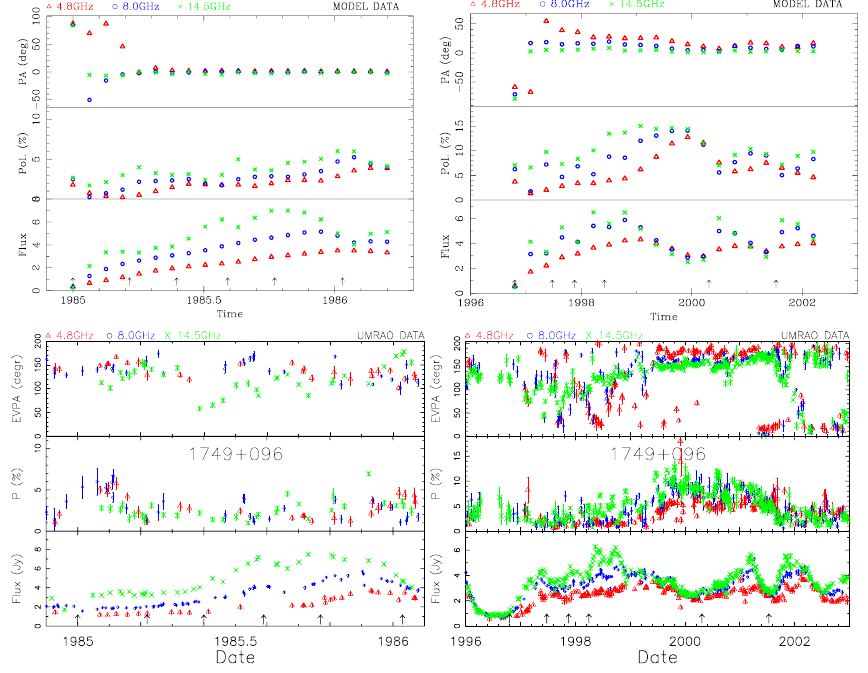
Figure 2. Comparison of the observed light curves in the form of daily-averaged data (bottom plots) and simulations (top plots) for epochs T1985 (left) and T1996 (right) showing time in years. The data at the three frequencies are symbol and color coded to match in the data and simulations. The simulated light curves were computed for 20 time steps using the adopted flow parameters listed in Table 1 and the values of the shock attributes listed in Appendix A Tables A1 and A2. Upward black arrows mark the adopted shock onset